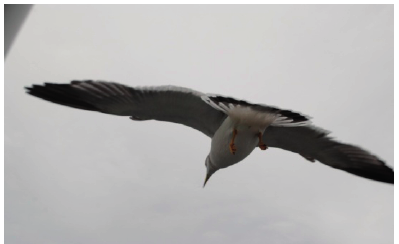
Figure 1. Albatross in